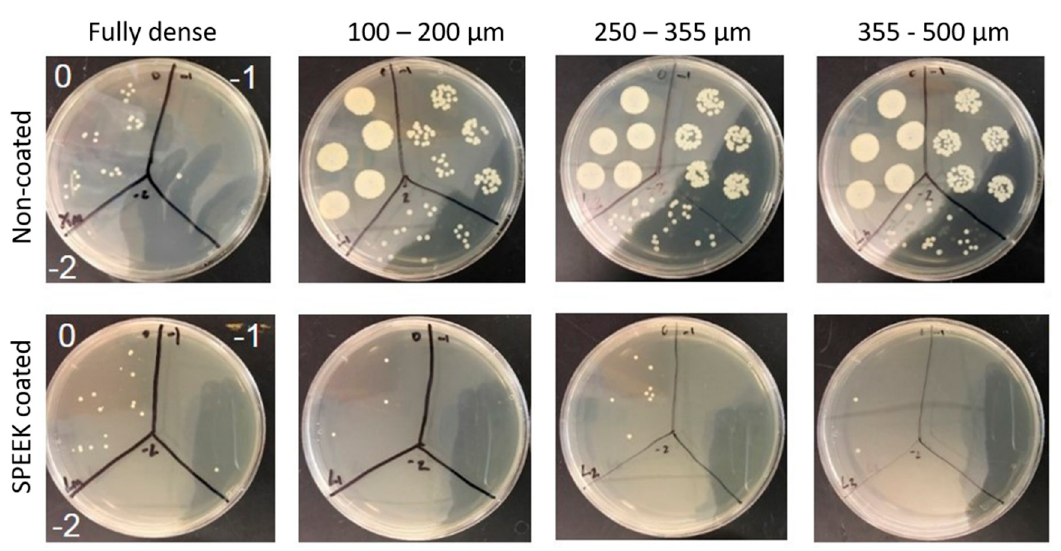
Figure 12. Colony-forming units for MRSA for the di ff erent coated and uncoated substrates (fully-dense and porous Ti-substrates with di ff erent ranges of spacer particle sizes). Macro-photography of CFU numbers grown in agar plates using three di ff erent concentrations (0, − 1 and − 2 dilutions) reproduced from [39], with permission from Elsevier, 2019.